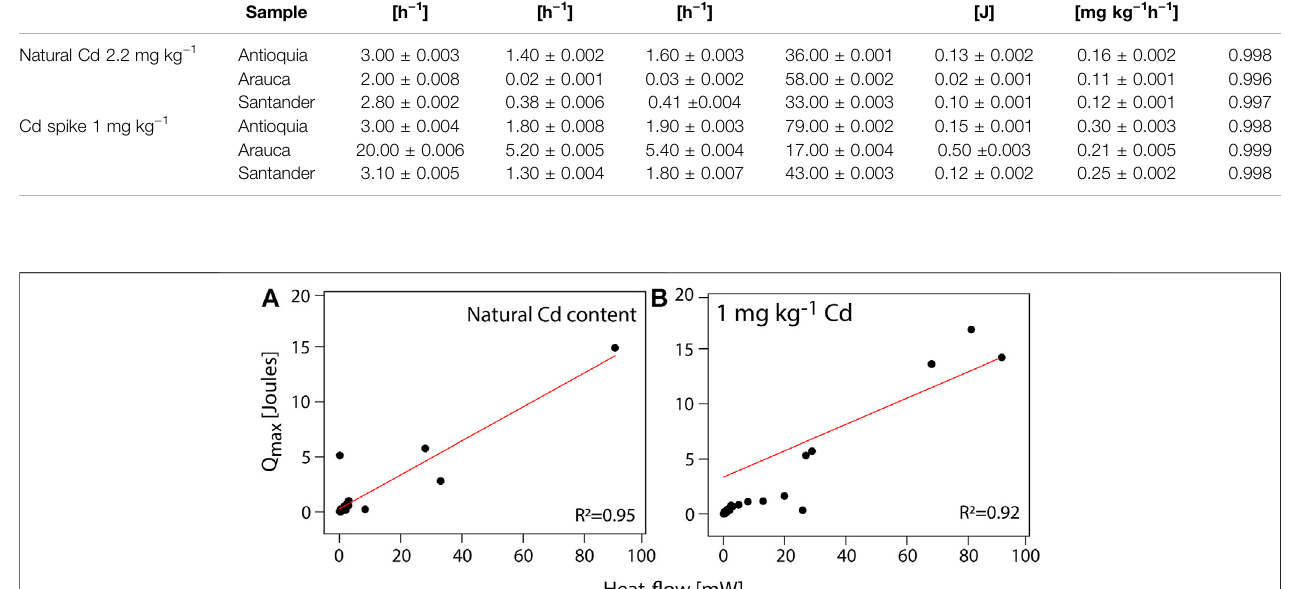
TABLE 2 | The kinetical growth and the thermodynamic parameters found in the assessed composite soil samples from Antioquia, Santander and Arauca. The parameters were calculated fi tting the Gompertz equation with the edited data obtained from the heat- fl ow over time (thermograms), by IMC. Soil Sample